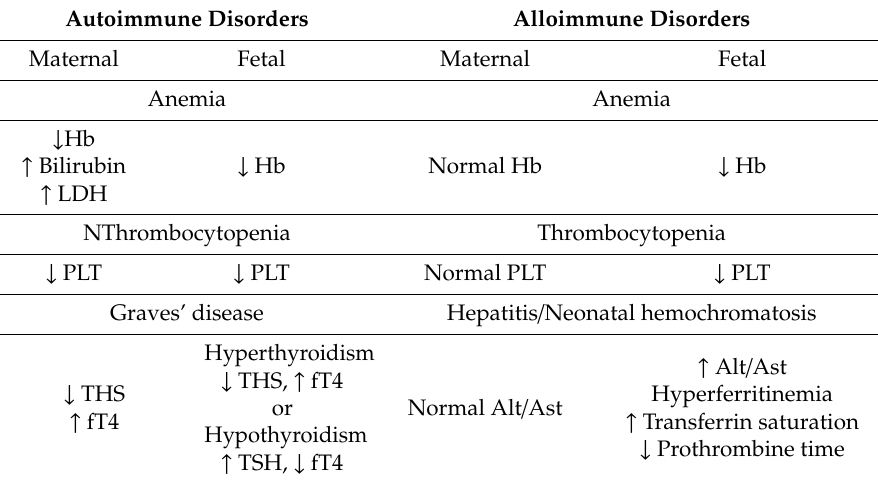
Table 1. Maternal and fetal laboratory changes in di ff erent